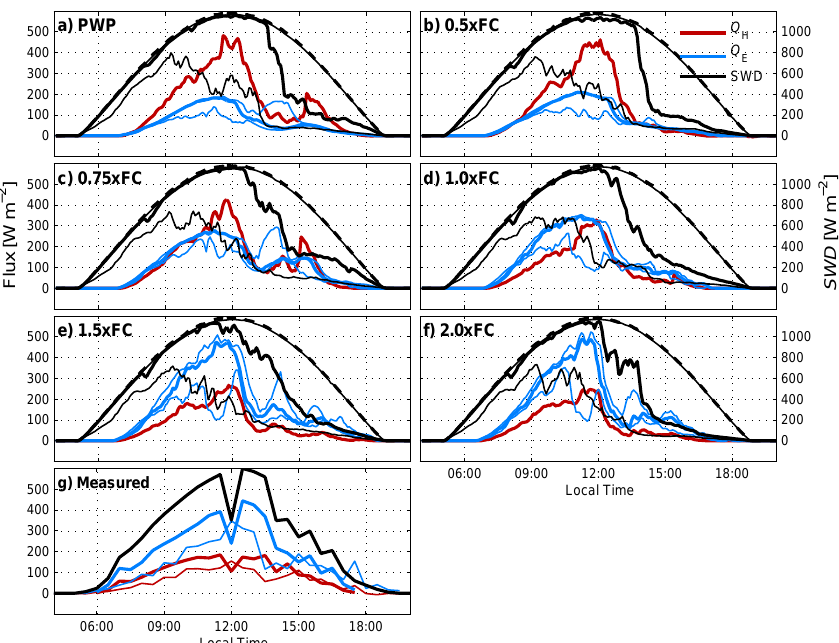
Figure 5. Development of turbulent surface fluxes in the Nam Co Lake basin for cases PWP, 0.5 × FC, 0.75 × FC, 1.0 × FC, 1.5 × FC and 2.0 × FC on 17 July 2012 (a–e) . Thick black lines correspond to the median flux over land. For SWD and Q E also the upper and lower quartiles are given as thin lines, presenting a measure of spatial flux variation. The dashed line is clear-sky SWD; (g) measured turbulent fluxes near Nam Co research station. Thin lines correspond to directly measured eddy-covariance fluxes. Thick lines are energy-balance corrected fluxes according to Twine et al.